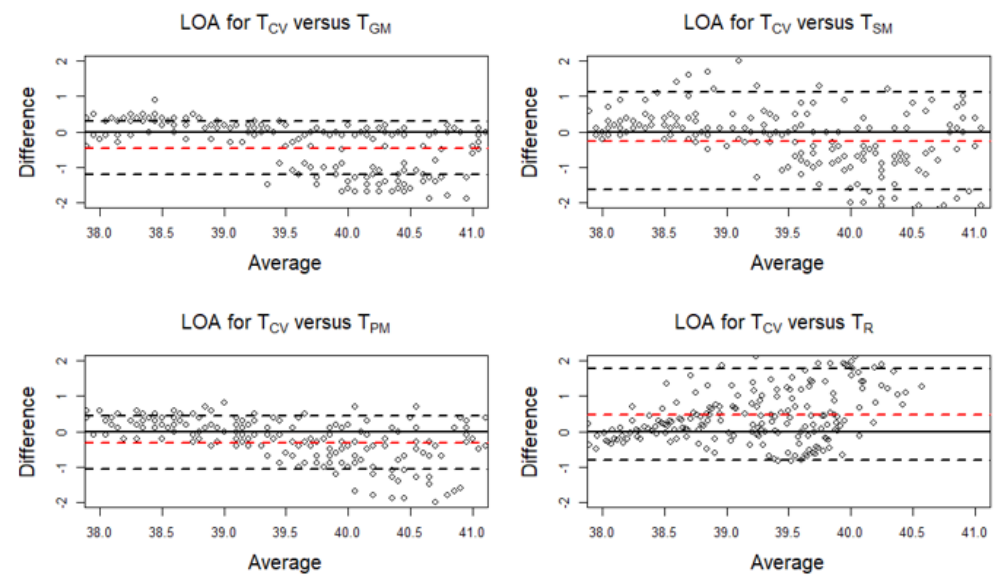
Figure 8. Limits of agreement (LOA) plots for the temperature pairs (T CV / T GM , T CV / T SM , T CV / T PM , and T CV / T R ) during Phases B (exercise on the treadmill) and D (cool-down walk). The red horizontal dashed line indicates the mean bias. The black horizontal dashed lines indicate the upper and the lower limit. T CV = central venous temperature, T PM = pectoral muscle temperature, T GM = gluteal muscle temperature, T SM = splenius muscle temperature, T R = rectal temperature.